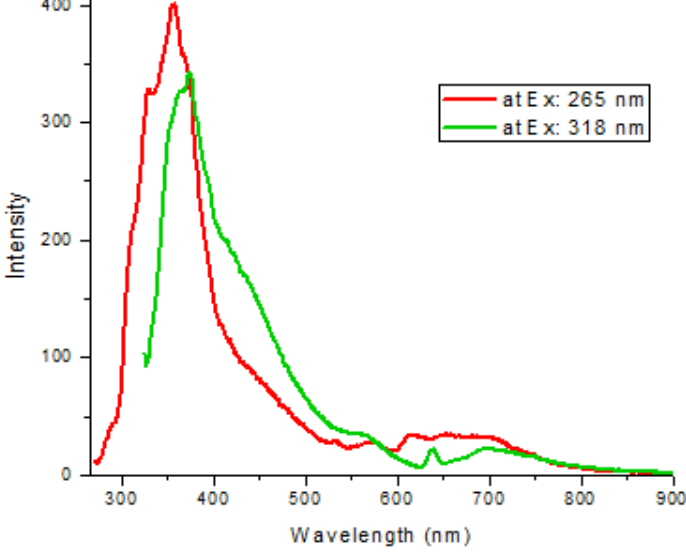
Figure S20: Emission spectra of Schiff base polymer P o HONPD at different excitation